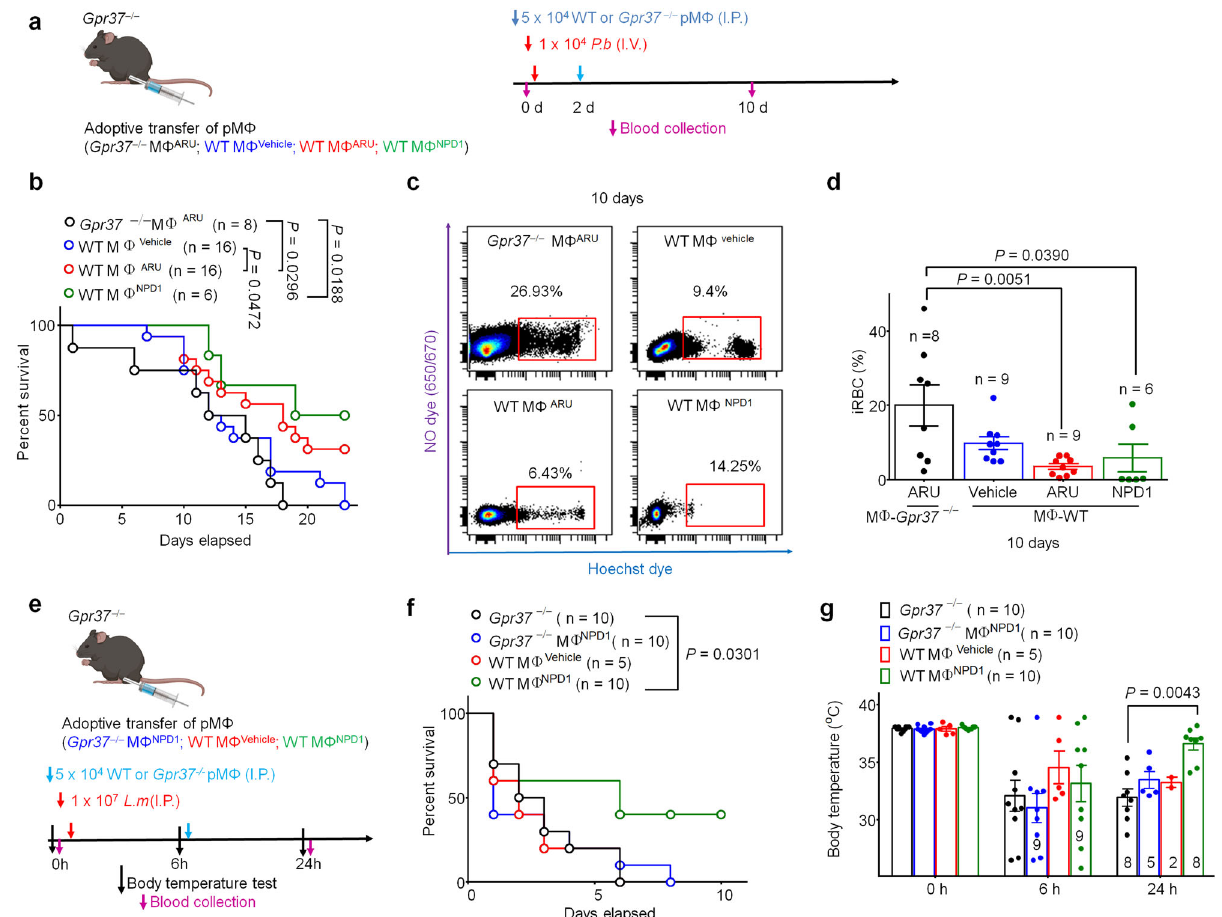
Fig. 7 Adoptive transfer of macrophages primed with Gpr37 activators confers protection against malaria and listeria infection. a Experimental design to test whether adoptive transfer of pM Φ primed with Gpr37 activators can attenuate malaria infection. WT or Gpr37 − / − pM Φ were primed with vehicle, ARU (30 μ M), or NPD1 (30nM) for 24h, followed by washout of the drug and adoptive transfer of pM Φ (5×10 4, I.P.) into P.b .-inoculated Gpr37 − / − mice (1×10 4 sporozoites, I.V.) 2d after infection. b Survival curves of Gpr37 − / − mice treated with vehicle-, ARU-, or NPD1-primed WT pM Φ . As a control, Gpr37 − / − mice were also treated with ARU-primed pM Φ from Gpr37 − / − mice. Sample sizes are indicated in brackets. c , d Flow cytometry analysis of peripheral blood samples taken from the mice outlined in a 10d after P.b . inoculation. Infected RBCs (iRBCs) were detected using Hoechst dye (1 μ g/ml) and negative for NO